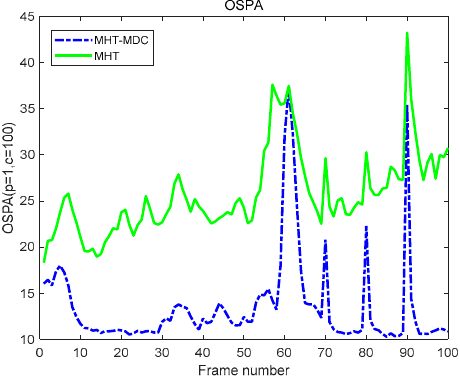
Figure 8. The estimated trajectories of the MHT in scenario 1.